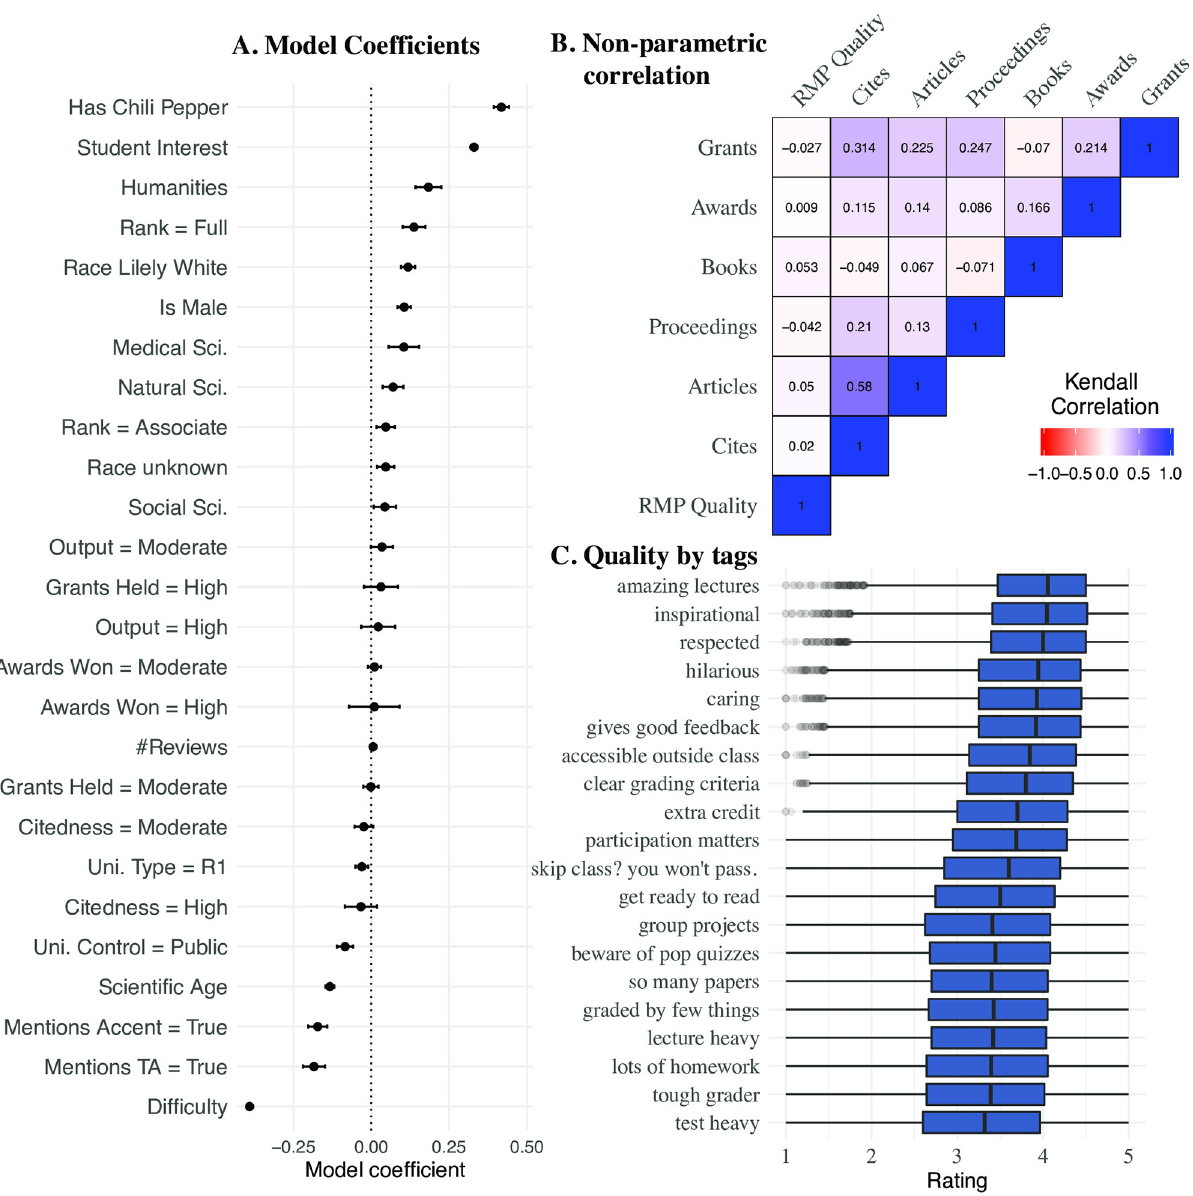
Fig 1. Individual, classroom, university, and research characteristics associated with overall teaching quality. A . Estimates of linear regression model using the overall teaching quality (continuous, 1-5) as the response and all variables from Table 1 as the predictor variables. The x-axis corresponds to the estimate for each covariate, which are listed along the y-axis. For binary variables, “false” is always used as the reference level. For Gender, “female” is used as the reference. For race, “Non-White” is used as the reference. For “Rank”, “Assistant” is used as the reference. For Discipline, “Engineering” is set as the reference. For Uni. Control, “Private” is used as the reference. For Uni. Type, “Not R1” is used as the reference. For all research indicators, “Low” is used as the reference. Error bars surrounding each point correspond to the 95 th percentile confidence intervals. Results are also shown in S4 Table. B . The non-parametric Kendall Rank Tau between research indicators and overall teaching quality. Values map to the correlation between 1 (correlated) and -1 (inversely correlated). Raw values for this test can be found in S5 Table. C . The distribution of overall teaching quality ratings for faculty possessing each of the pre-defined “tags” listed on their RateMyProfessor.com profile.